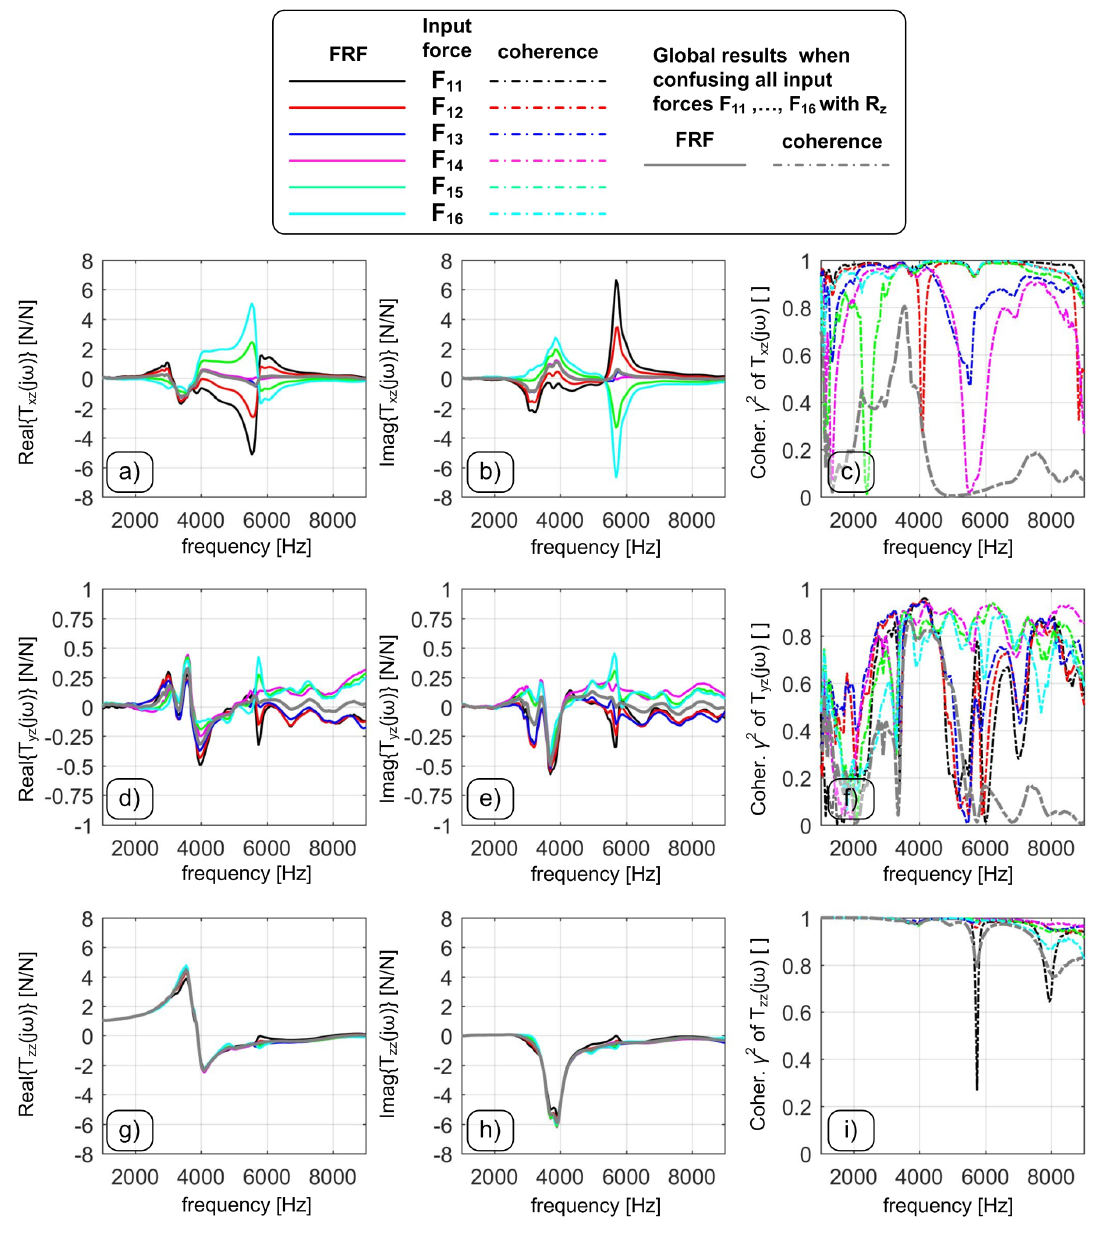
Figure 2. The real part, imaginary part and coherence function of the cross TFRF T xz are illustrated in ( a ), ( b ) and ( c ), respectively. Different colors refer to different input force conditions F p , though all along the Z direction. Similarly the real part, imaginary part and coherence function of the cross TFRF T yz are illustrated in ( d ), ( e ) and ( f ), respectively. Eventually, the real part, imaginary part and coherence function of the direct TFRF T zz are illustrated in ( g ), ( h ) and ( i ),